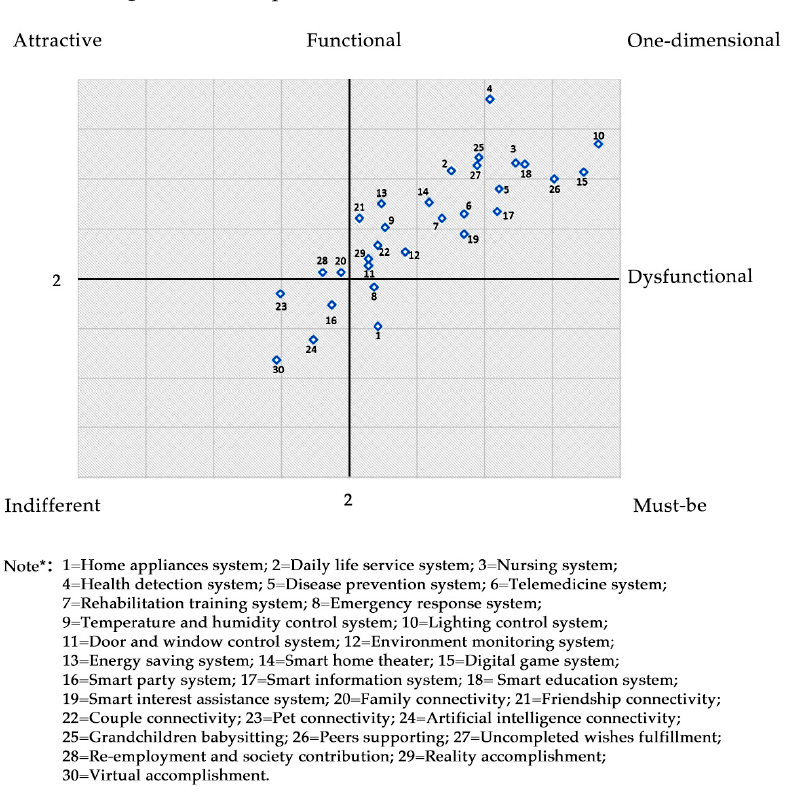
Figure 5 . The attribute distribution in the Kano Model Figure 5. The attribute distribution in the Kano